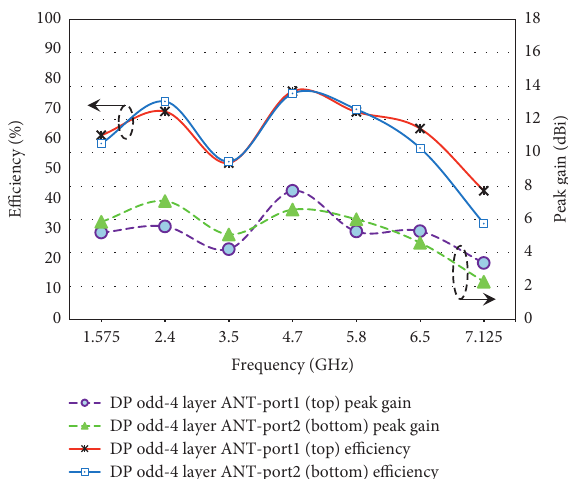
Figure 13: Measured antenna peak gain and efficiency versus frequency of the proposed